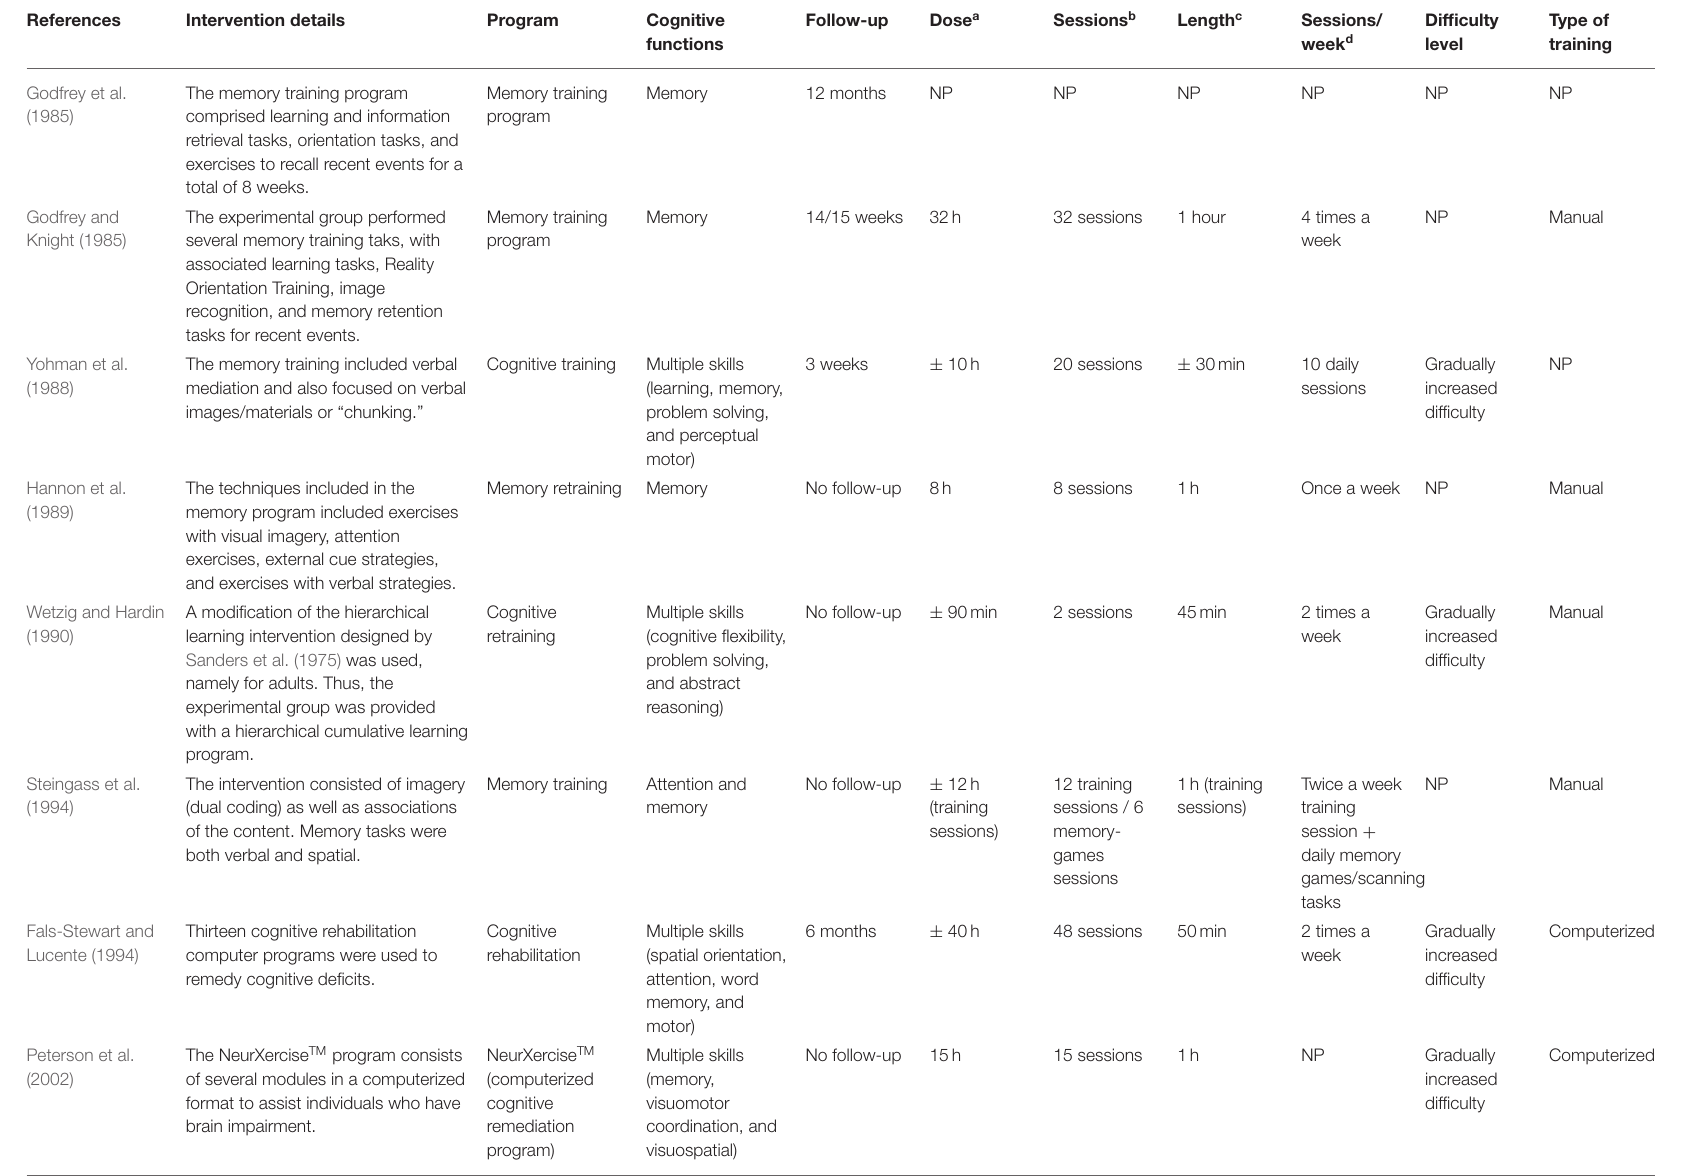
TABLE 3 | Intervention